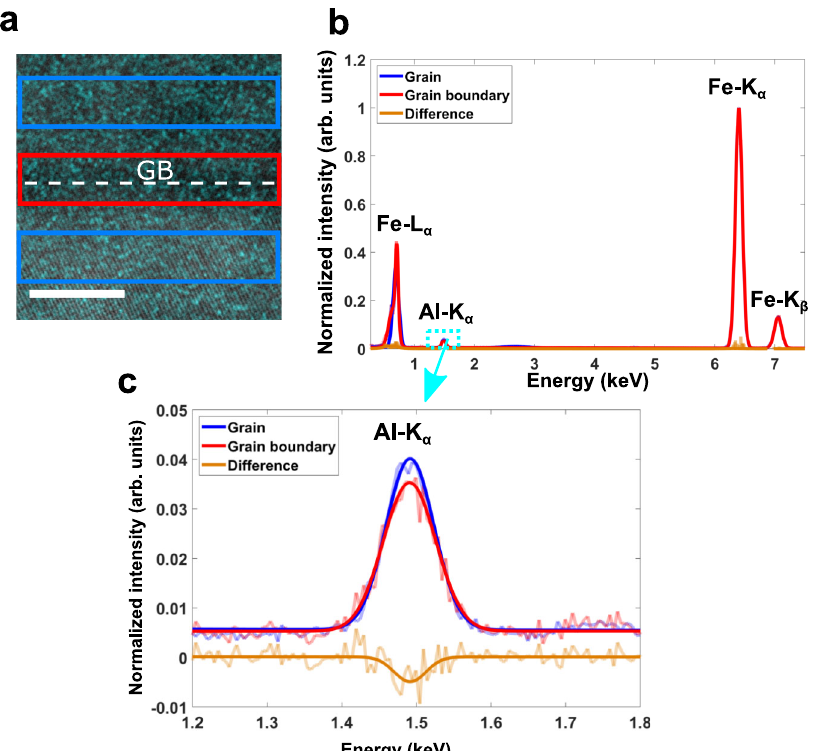
Fig. 4 Elemental distribution of Al at the Σ 5 (3 1 0) GB. a Overlay of the HAADF-STEM image and the Al-K elemental map taken across the Σ 5 (3 1 0) GB. The colored boxes indicate the location where the spectra in ( b ) were summed. b Summed EDS spectra, which were normalized to the Fe-K α peak, extracted from the grain interior (blue) and the GB (red). The corresponding difference spectrum is shown in orange. In order to minimize effects from differences in peak shapes, the spectra were fi tted by a Gaussian function. c A magni fi ed view of the Al-K α edge indicates a slight decrease of Al at the GB. The semitransparent curves in ( b and c ) display the raw spectra, the solid lines the Gaussian fi t. The Scale bar in ( a ) is 5